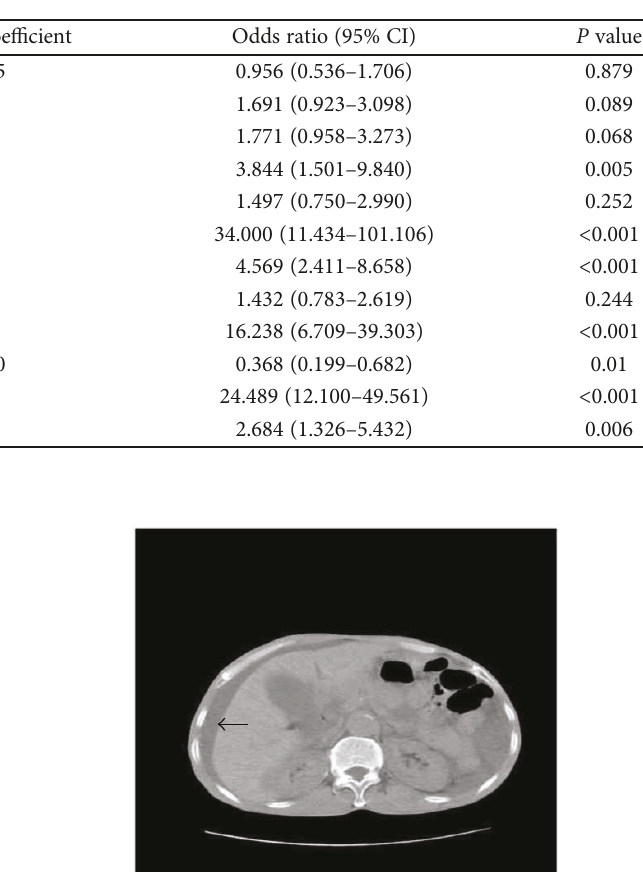
Table 3: Univariate analysis for comparison of 172 patients with small bowel obstruction who underwent conservative treatment with 76 who had surgery for SSBO.